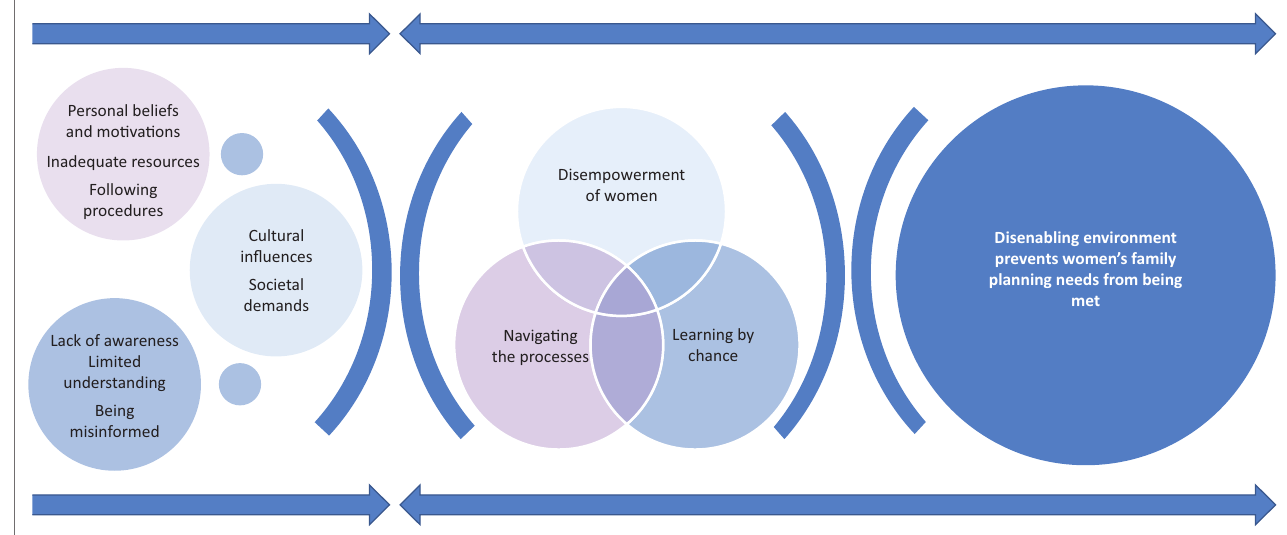
FIGURE 1: Disenabling environment prevents women’s family planning needs from being